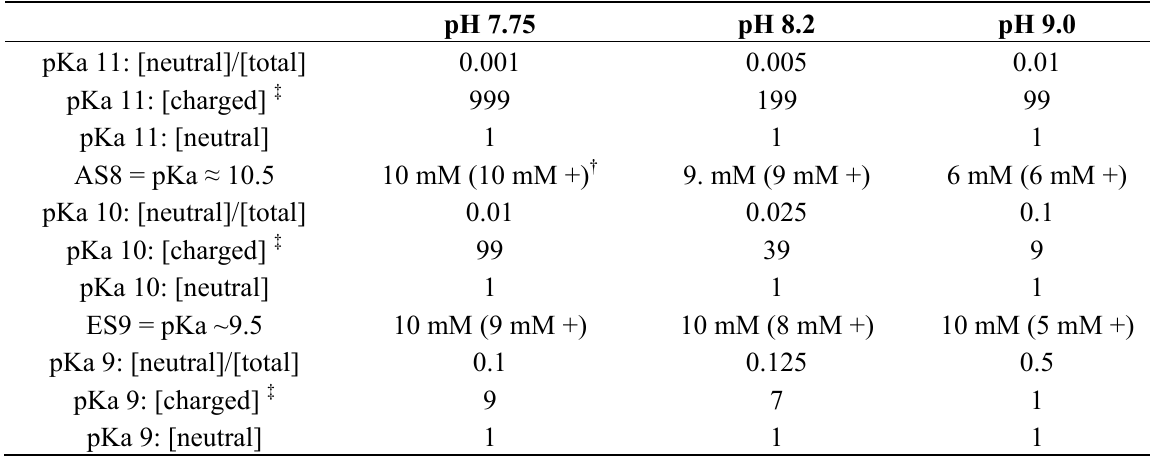
Table 2. Trend estimations of cationic peptide concentrations §